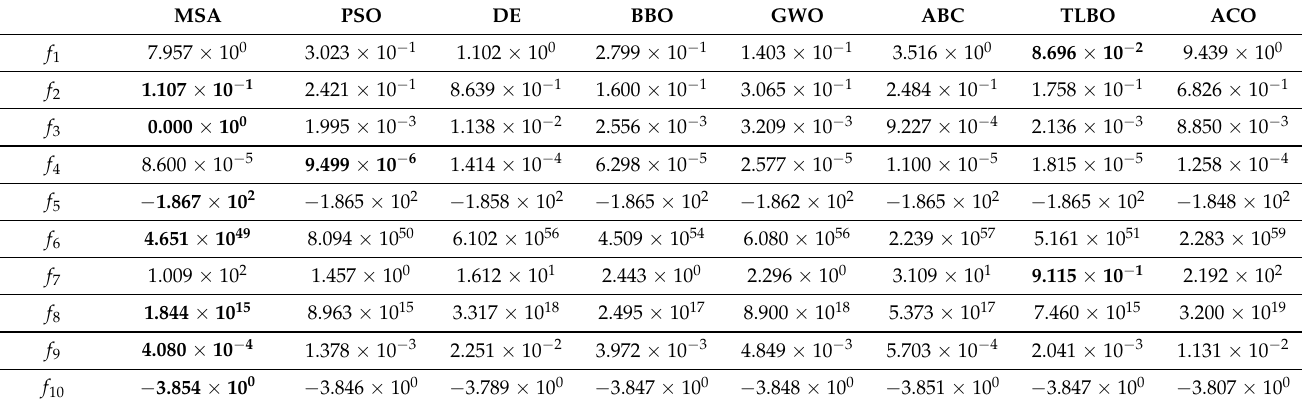
Table 1. Performance evaluation (per test function) of MSA against selected meta-heuristic algorithms (the best values are indicated in bold).